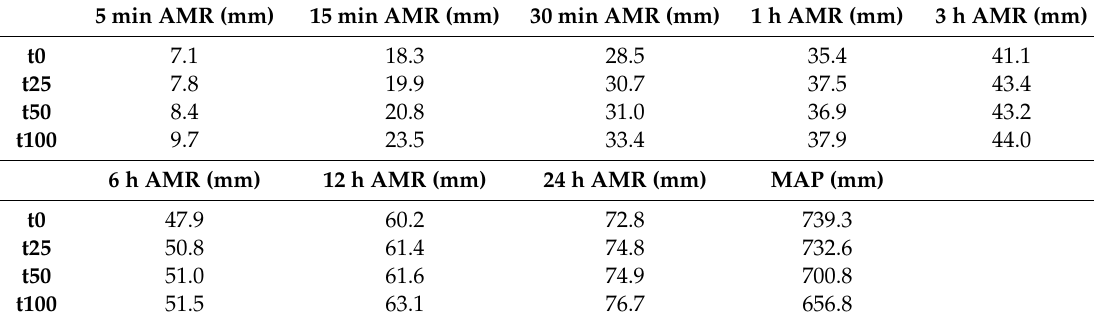
Table 5. Evolution of average values for Annual Maximum Rainfall (AMR) and of Mean Annual Precipitation (MAP): from now (t0) to 25 (t25), 50 (t50), 75 (t75) and 100 (t100) years.